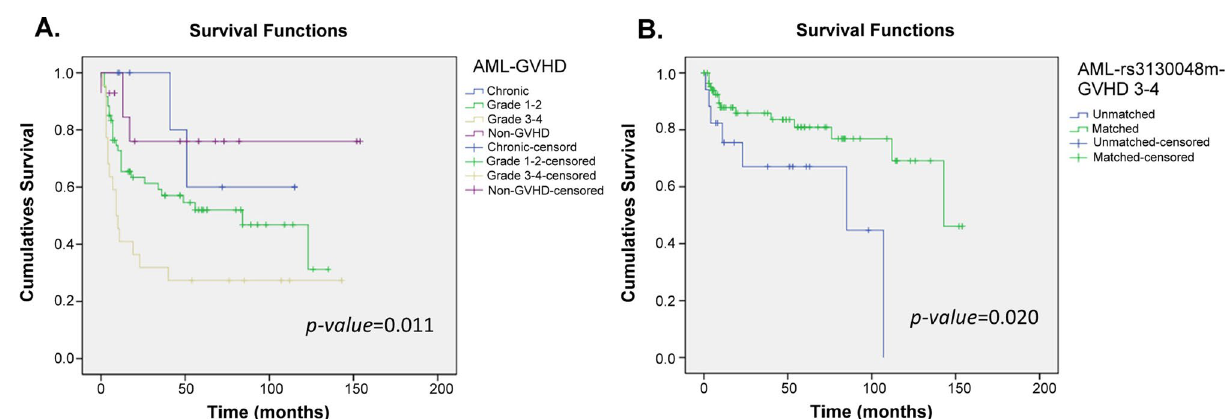
Figure 4. Kaplan–Meier analysis of overall survival curves based on the grade of GVHD and GVHD-related SNPs in AML patients. ( A ) The survivorship curve of GVHD in AML patients. ( B ) The rs3130048 of BAG6 in donor-recipient pairs. censoring: the time point of patient death or losing contact; x-axis: the time from receiving transplantation to death. y-axis: the ratio of surviving